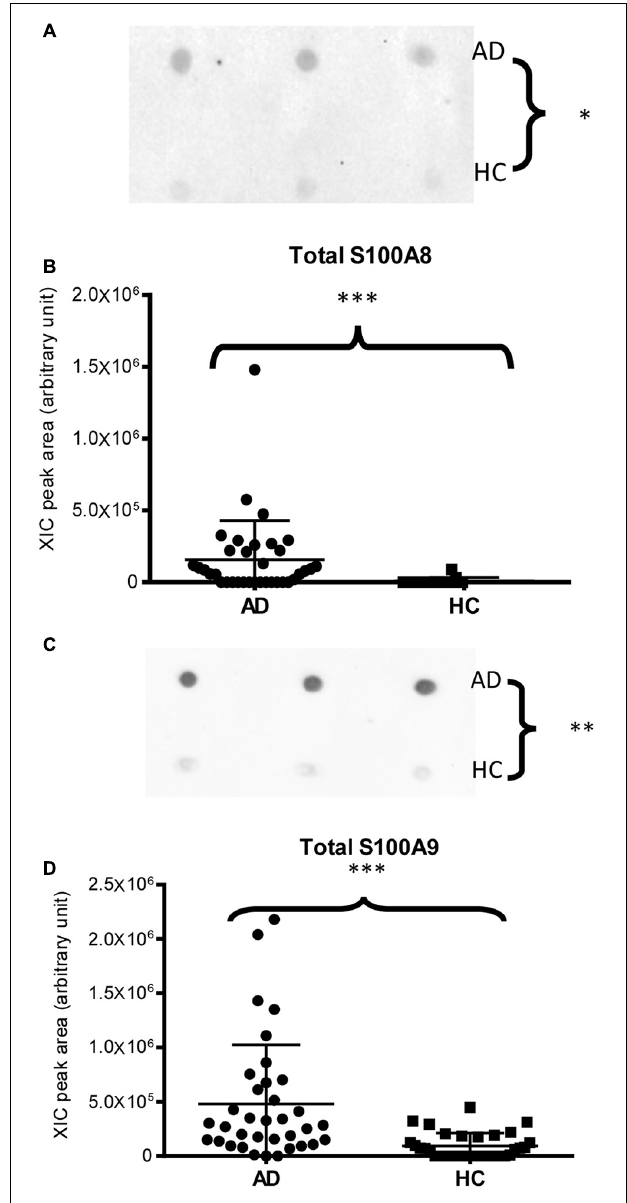
FIGURE 2 | Dot-blotting immunodetection of total S100A8 (A) and total S100A9 (C) in salivary pools of AD and HC samples and distribution plot of the XIC peak area values of total S100A8 (B) and total S100A9 (D) measured by HPLC-ESI-MS in each salivary sample from the AD and HC groups (XIC peak areas of all the identified proteoforms of S100A8, such as S100A9, were considered in the sum, see Supplementary Table 2 ) ( ∗ , p < 0.05; ∗∗ , p < 0.01; ∗∗∗ , p <